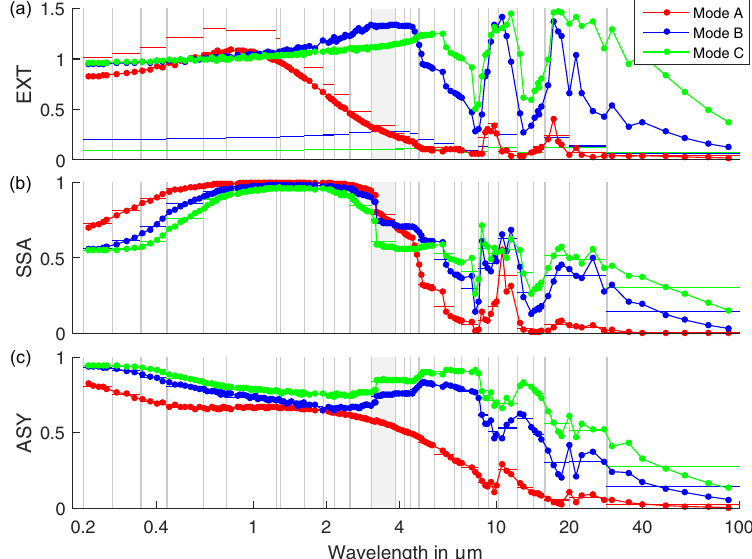
Figure 2. Results from Mie calculations as used by ICON-ART. Points are normalized with respect to the value at 550nm; horizontal lines show absolute values. Shown are (a) the extinction coefficient (EXT) in m 2 g − 1 , (b) the single scattering albedo (SSA) and (c) the asymmetry parameter (ASY) for all modes. The borders of the RRTM radiation scheme wavebands are outlined as grey lines in the background. The filled grey band represents the waveband present both in the longwave and shortwave part of the